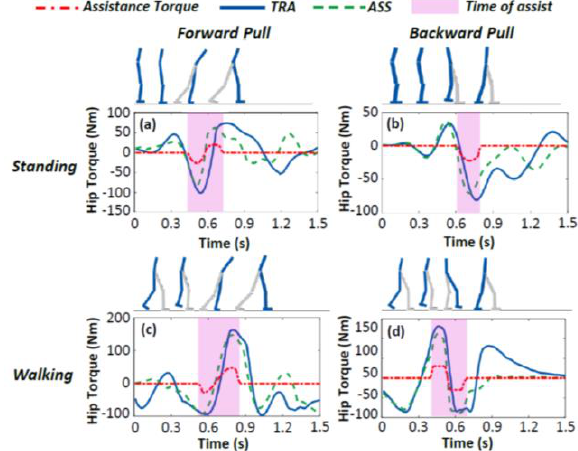
Figure 15. The hip joint angle: ( a ) Forward pull while standing; ( b ) Backward pull while standing; ( c ) Forward pull while walking; ( d ) Backward pull while walking.